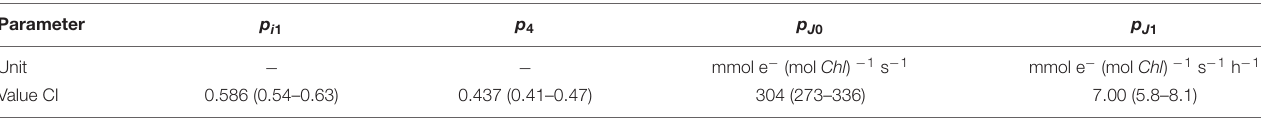
TABLE 3 | Parameter estimates for the fit of Equations 5, 10 to measure J max and V cmax in tomato.